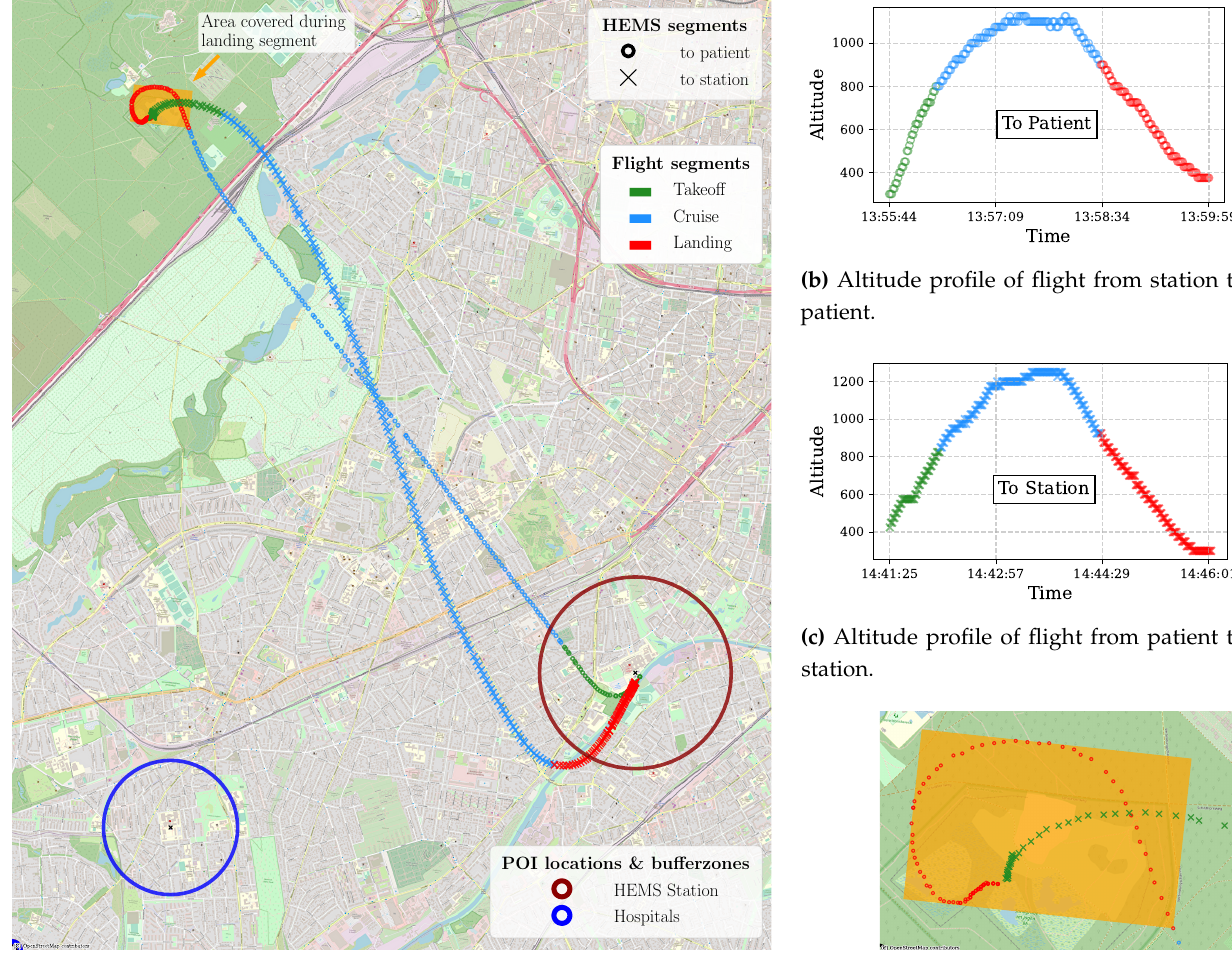
Figure 2. Example flight consisting of two HEMS segments (altitude profiles with associated altitude profiles and landing